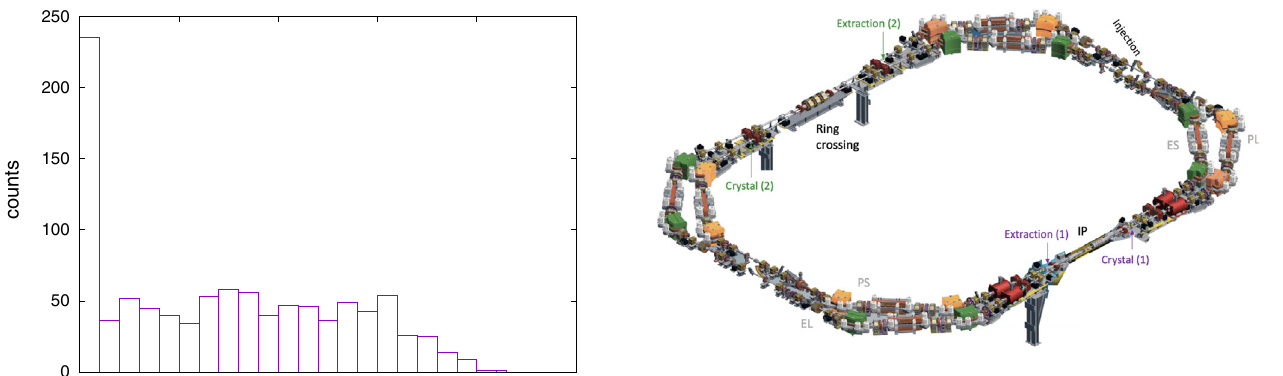
FIG. 8. Nonlocal extraction scheme locations using the DA Φ NE positron main ring; particles are injected in the long external arc (PL) and circulate clockwise: in option (1) the crystal and the septum are placed upstream and downstream the main experiment interaction point, in case (2) they are placed around the ring crossing region on the opposite side.